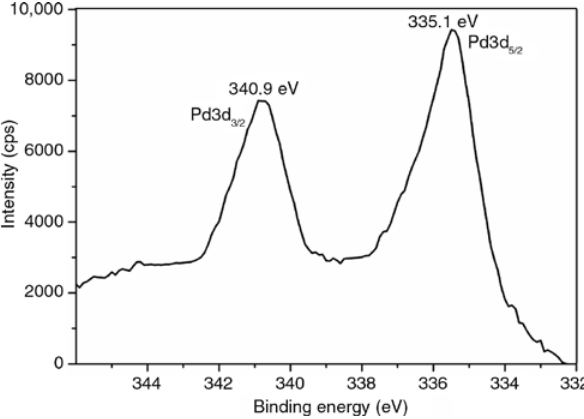
Figure 1: X-ray photoelectron spectroscopy (XPS) spectra of Pd o 3d.